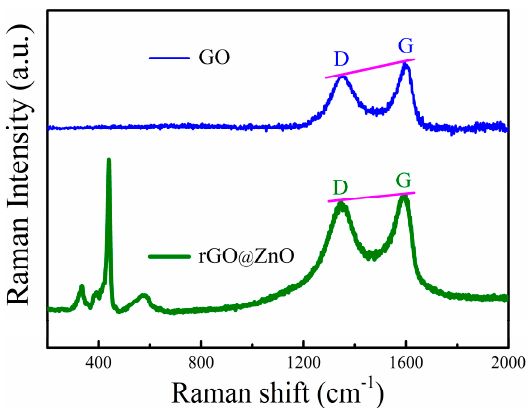
Figure 2. Raman spectra of the GO suspension and rGO@ZnO composites.